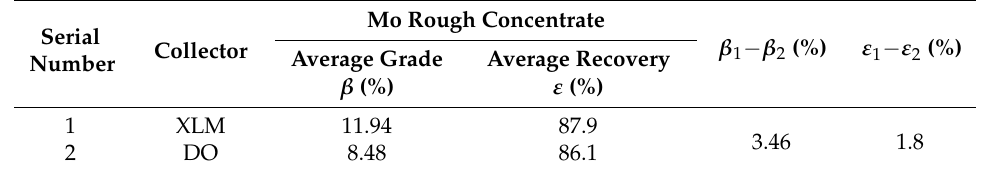
Table 1. Results analysis of comparison study between XLM and DO as the collector in Industrial- scale